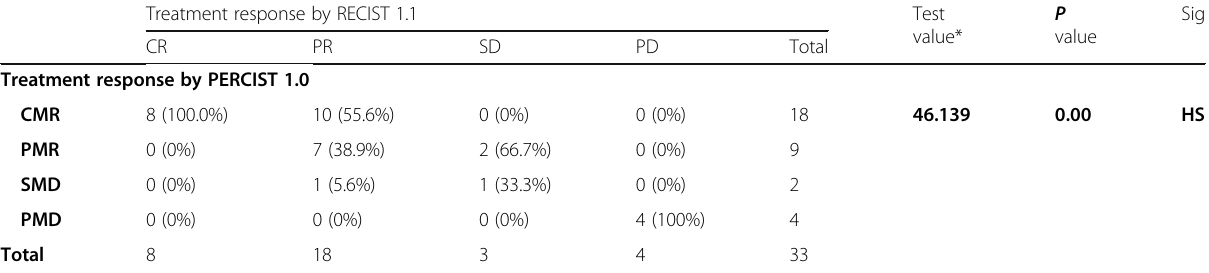
Table 8 Comparison between RECIST 1.1 and PERCIST 1.0-based therapeutic response assessment in the study population Treatment response by RECIST 1.1 Test